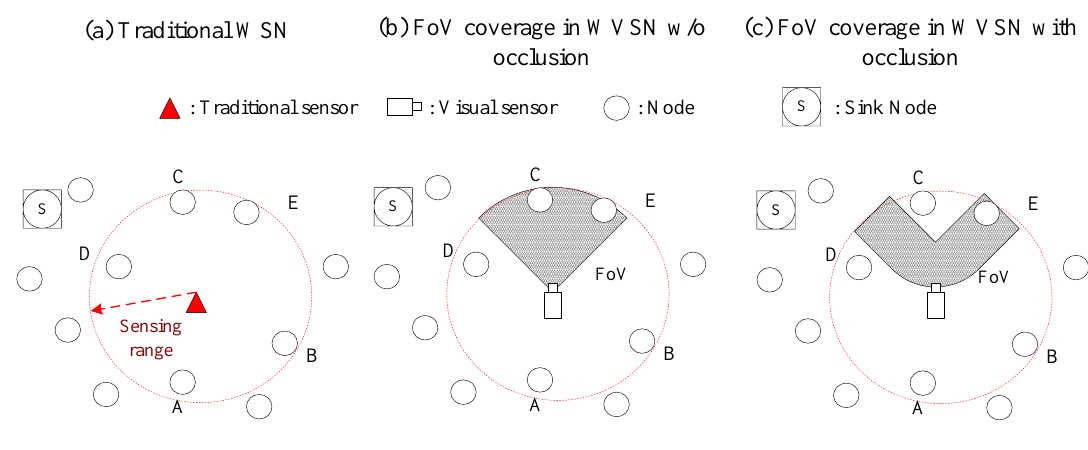
Figure 2. Sensor coverage in WSN and WVSN.